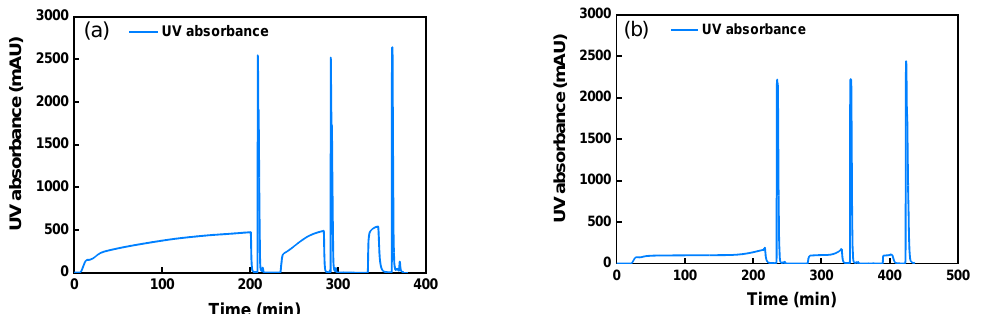
Figure 6. Chromatograms of bind-and-elute cycles at 0.1 min, 0.5 min, and 2.0 min RT, using 12 membrane layers of 10 mm diameter. After running at 0.5 min residence time, the membrane bed was replaced by a new one. Experiments performed to capture: ( a ) spiked IgG and ( b ) scFv from CHO culture supernatant. Table 2. Performance of capturing spiked IgG and scFv from CHO culture supernatant (protein